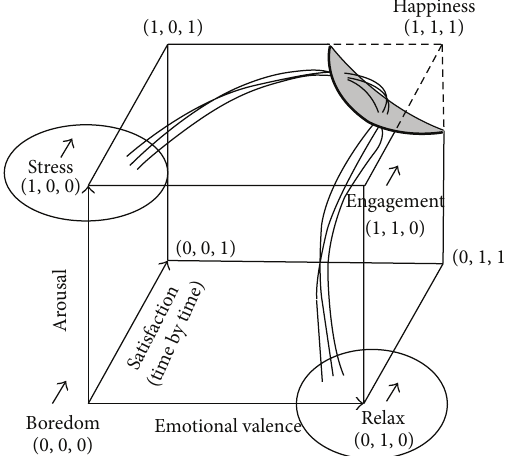
Figure 7: A representation of possible paths from relax to happiness experience to stress